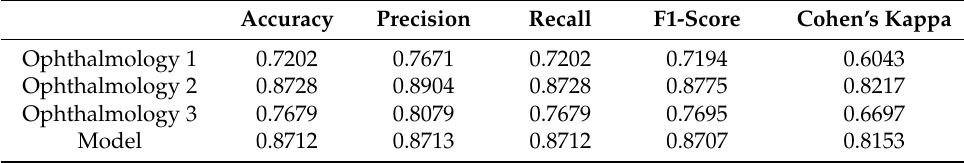
Table 1. Performance of the deep learning model grading bulbar conjunctival